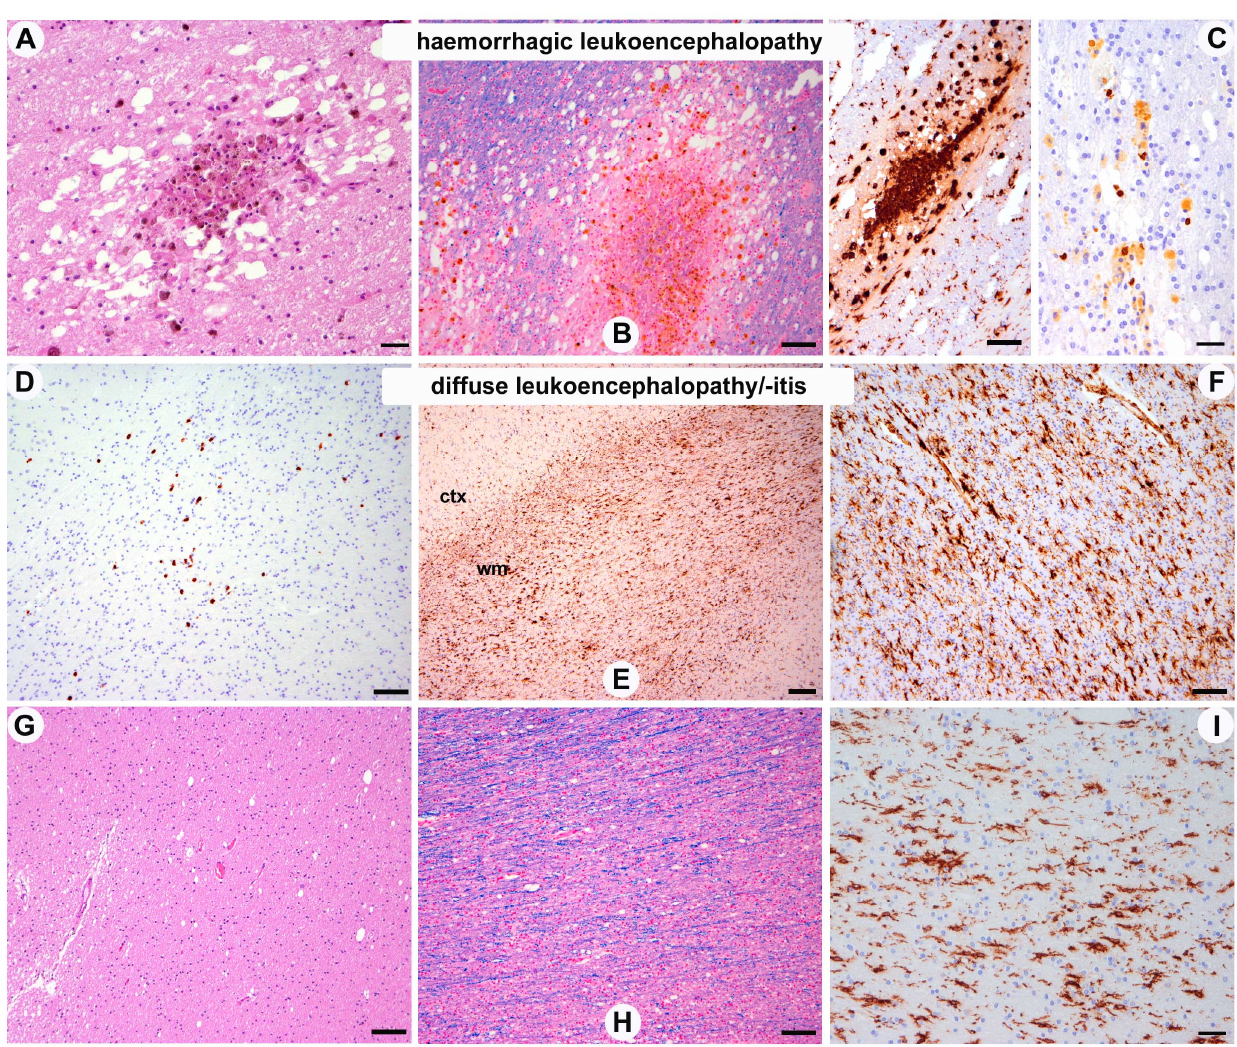
Figure 2. White matter pathology. ( A – C ) Multiple subacute hemorrhagic lesions throughout the white matter with hemosiderin-laden macrophages, surrounding Waller degeneration with axonal and myelin vacuolation (( B ), luxol fast blue), proliferation of macrophages and activated microglia (( C ), left panel anti-HLA-DR immunohistochemistry) and isolated CD8+ T-lymphocytes (( C ), right panel; case 4). ( D ) Focal cellular infiltrates of CD8+ T-lymphocytes in the white matter (case 2) and prominent diffuse microglial activation, particularly in the white matter, independently of T-cell infiltrates (( E , F ), anti-HLA-DR immunohistochemistry (ctx: cortex; wm: white matter). ( G – I ) mild to moderate diffuse vacuolation of white matter, better identified on luxol-fast-blue-stained sections, without signs of demyelination ( H ) and diffuse microglial activation, accentuated at the perivascular spaces (( I ), anti-HLA-DR immunohistochemistry) (( G – I ), case 5). Scale bars: ( A , C ) right panel, ( I ) 20 μm; ( B , C ) left panel, ( D , F – H ) 50 μm; (E) 100 μm.